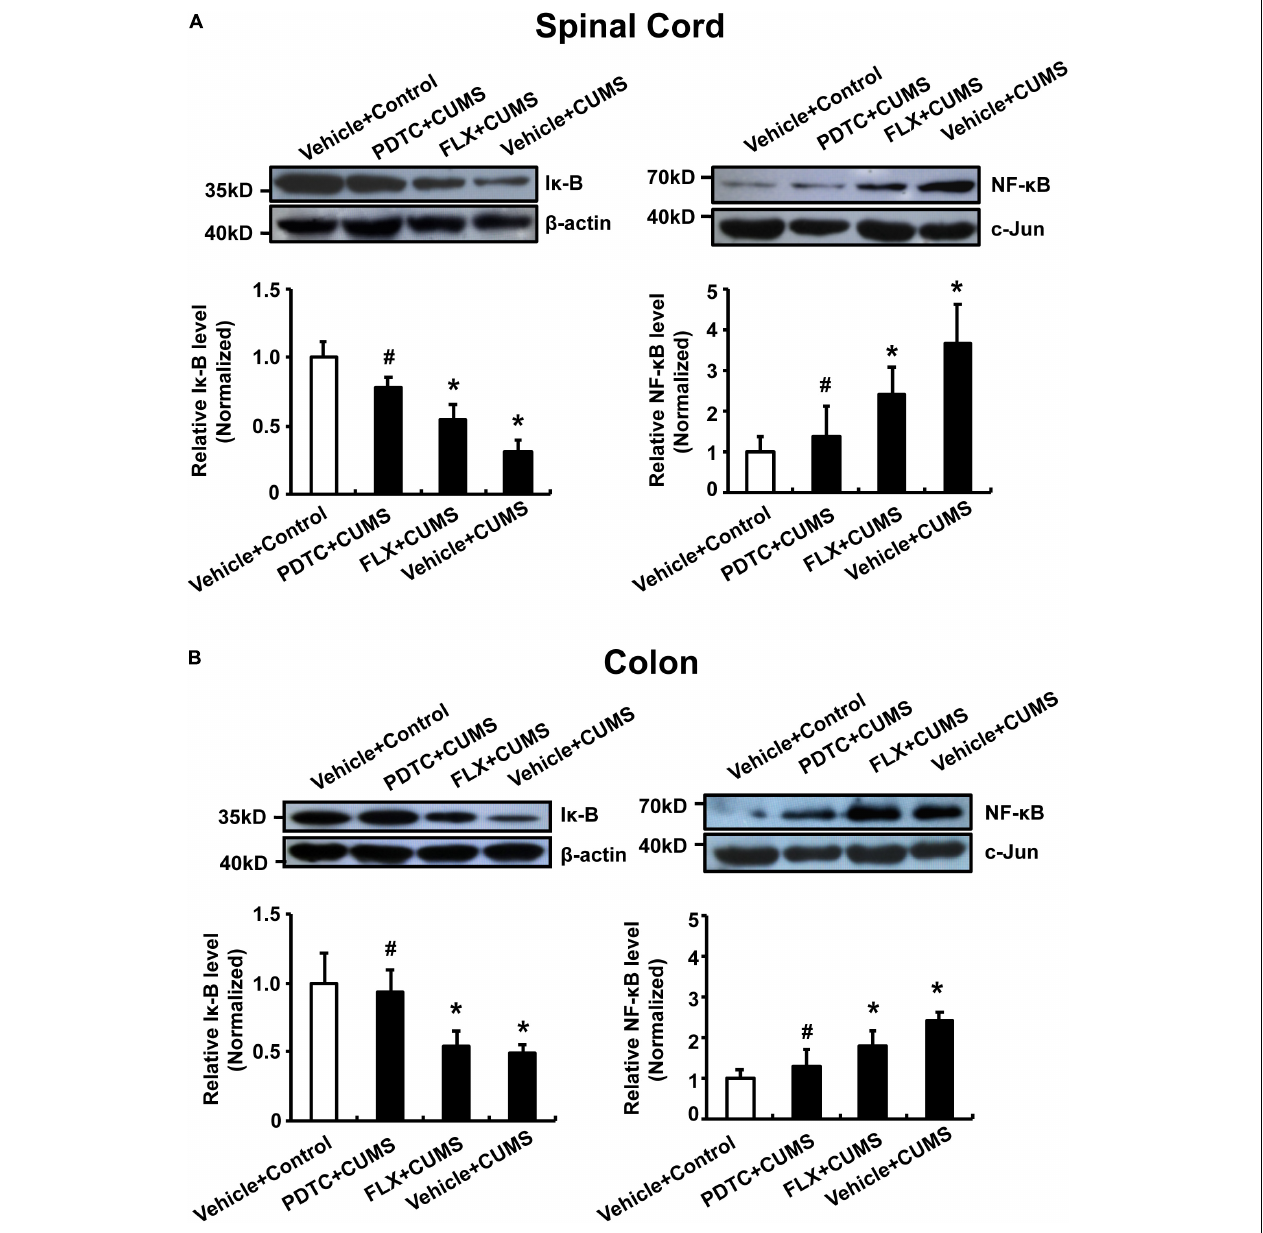
FIGURE 6 | Pyrrolidine dithiocarbamate prevented nuclear translocation of NF- κ B in the spinal cord and colon of CUMS rats. CUMS obviously reduced cytosolic I κ B levels and increased nuclear NF- κ B levels in both spinal cord and colon. Pretreatment with PDTC, but not fluoxetine, prevented CUMS-induced nuclear translocation of NF- κ B in spinal cord (A) and colon (B) . All values are presented as mean ± SEM. n = 6 versus the control group. # p < 0.05 versus the CUMS group. FLX,